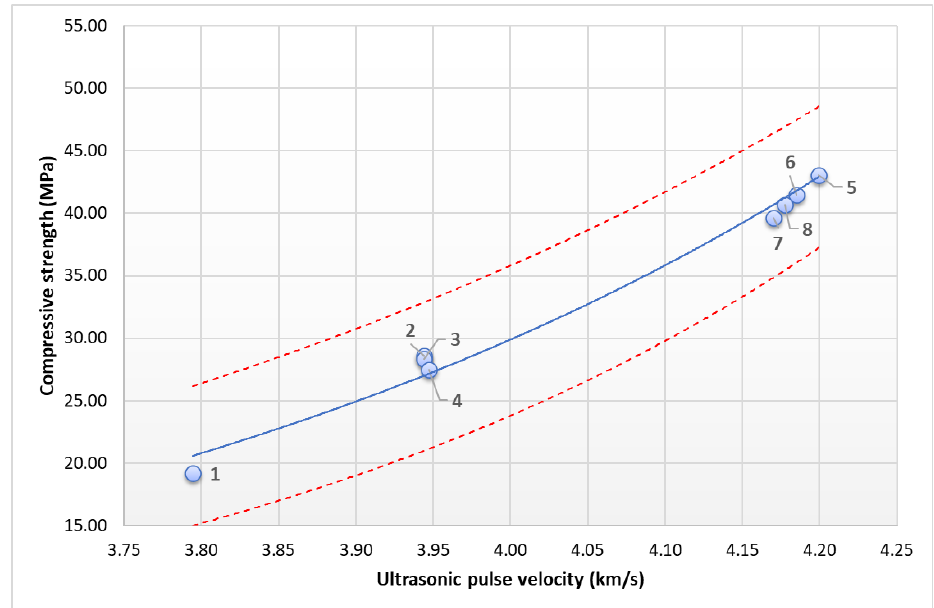
Figure 3. Presentation of the results of the compressive strength test concerning the calculated ultrasonic pulse velocity of the natural mordenite. The blue line represents the exponential trend of the values, and the red dashed lines represent the limits set with 95% confidence.